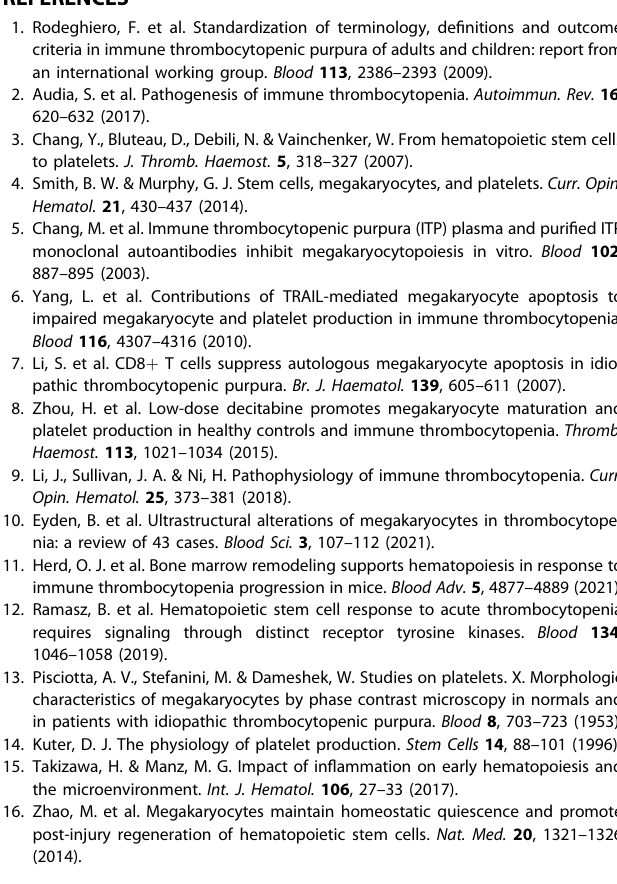
Fig. 9 ITP-associated alterations in MkP subclusters. a TOP 5 GO: BP terms enriched in each MkP subcluster. b Heat maps showing the distribution of downregulated DEGs (left) and upregulated DEGs (right) between ITP and HC samples in each MkP subcluster. The gray bars on the left of the heat maps denote DEGs shared by at least two subclusters, while the others are subcluster-speci fi c DEGs. c Volcano plots highlighting signi fi cant differences in gene expression between ITP and HC in MkP-IV (left) and MkP-V (right). Red points represent signi fi cantly upregulated genes, blue points represent signi fi cantly downregulated genes, and gray points represent non-differentially expressed genes. Genes with an adjusted p value < 0.05, log-transformed fold change absolute value >0.25, and minimum percentage >0.25 were considered as differentially expressed genes. d Boxplot showing the expression of DEGs in MkP-V. e Two-sided bar graph showing the top 10 enriched upregulated and downregulated GO terms in MkP-V in ITP. f GSEA plots showing representative pathways enriched in MkP-V from ITP versus HC. NES normalized enrichment score, NOM p value nominal p value, FDR q value false discovery rate q value. g GSEA plots showing representative pathways enriched in MkP-V from HC versus ITP. NES normalized enrichment score, NOM p value nominal p value, FDR